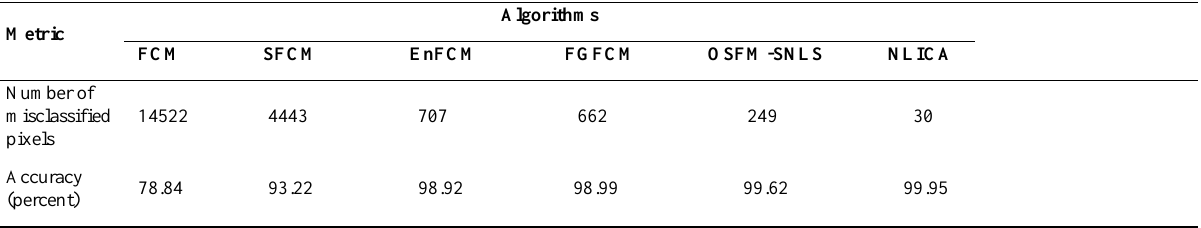
Table 3. Segmentation results of image number 3.